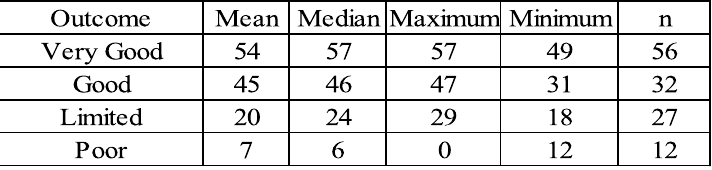
Table 2 Outcome categories at 3 months after stroke based on ARAT